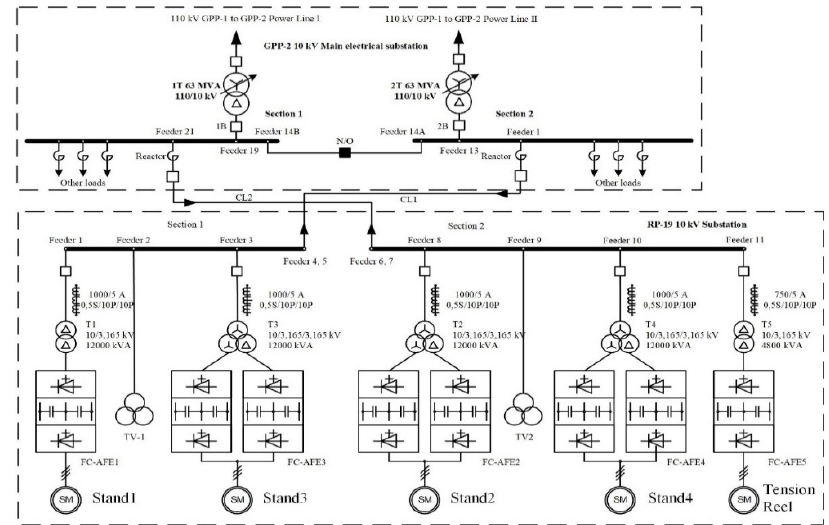
Figure 14. The grid diagram for the key electric drives of the cold-rolling mill.